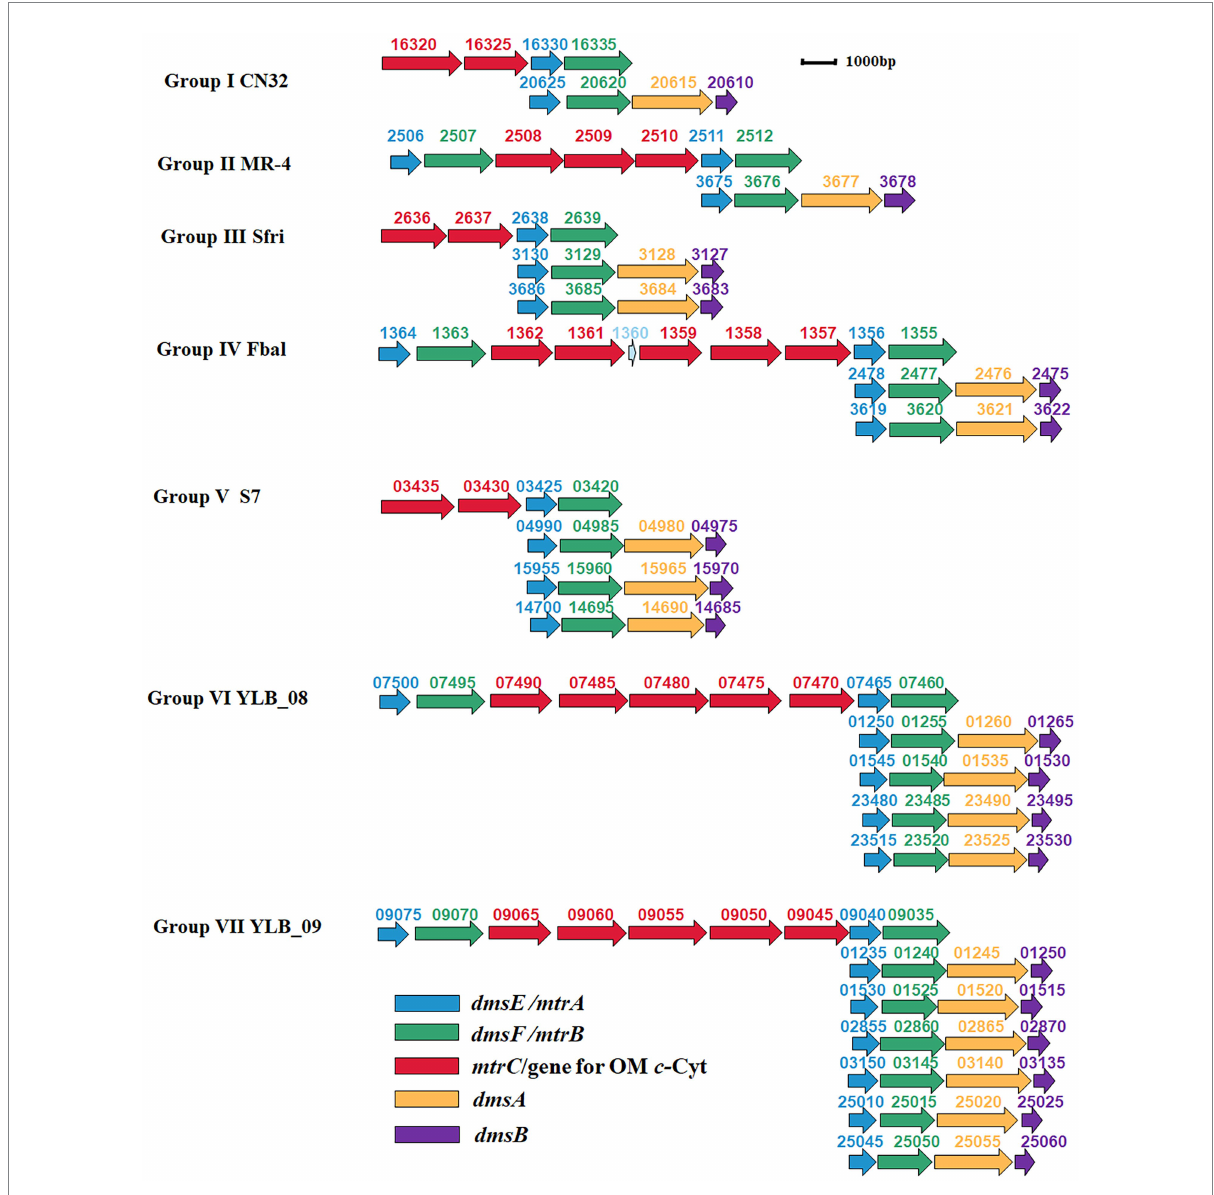
FIGURE 3 Genetic organization of identified mtrCAB and dmsEFAB gene clusters. The relative positions of genes identified within the complete genomes are shown. The identified genes are labeled with arrows. The arrow sizes indicate the relative lengths of identified genes. The arrow orientation indicates the presumed direction of gene transcription. The numbers above the identified genes are part of their locus tags. Group I: S. japonica KCTC 22435, S. livingstonensis LMG 19866, S. putrefaciens CN32 (CN32), S. woodyi ATCC 51908, Shewanella sp. ARC9_LZ, Shewanella sp. SUN WT4 and Shewanella sp. WPAGA9; Group II: S. fidelis ATCC-BAA-318, S. marisflavi EP1, S. piezotolerans WP3, S. schlegeliana JCM 11561, S. xiamenensis NUITM-VS1, Shewanella sp. 8A , Shewanella sp. ISTPL2, Shewanella sp. LZH-2, Shewanella sp. MBTL60-112-B1, Shewanella sp. MBTL60-112-B2 and Shewanella sp. MR-4 (MR-4); Group III: Ferrimonas sp. SCSIO 43195, S. frigidimarina NCIMB 400 (Sfri), Shewanella sp. Actino- trap-3 and Shewanella sp. KX20019; Group IV: Ferrimonas balerica DSM 9799 (Fbal) and S. oneidensis MR-1; Group V: F. lipolytica S7 (S7) and S. psychromarinicola M2; Group VI: S. eurypsychrophilus YLB-08 (YLB-08); and Group VII: S. sediminis HAW-EB3 and Shewanella sp. YLB-09 (YLB-09). OM c -Cyt: the outer membrane c -type cytochrome. See text for